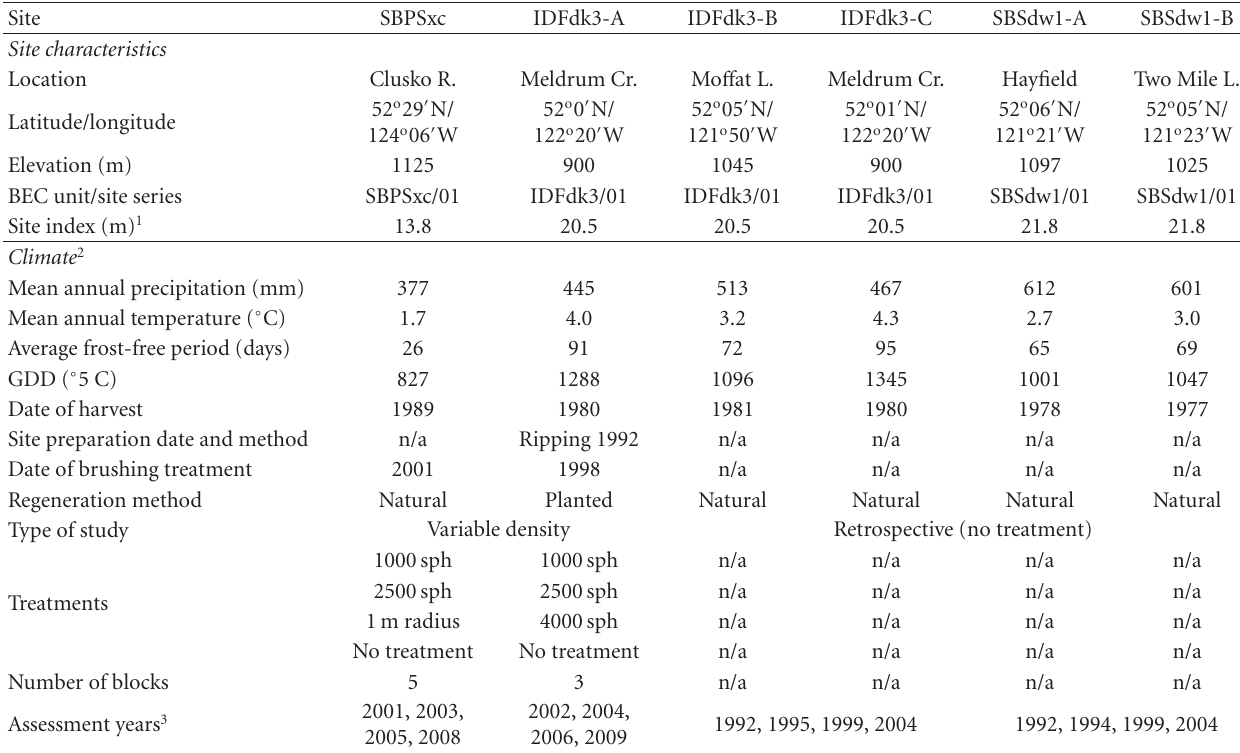
Table 1: Site, climate, and treatment information for study